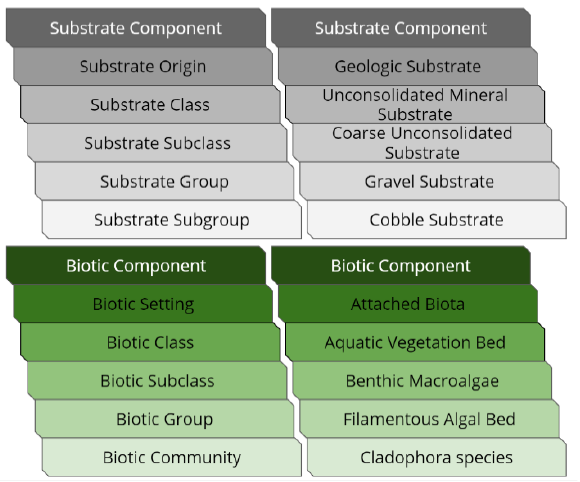
Figure 5. Hierarchical structure of the substrate and biotic components within the Coastal and Marine Ecological Classification Standard (CMECS), including individual units ( left ) and class examples ( right ).